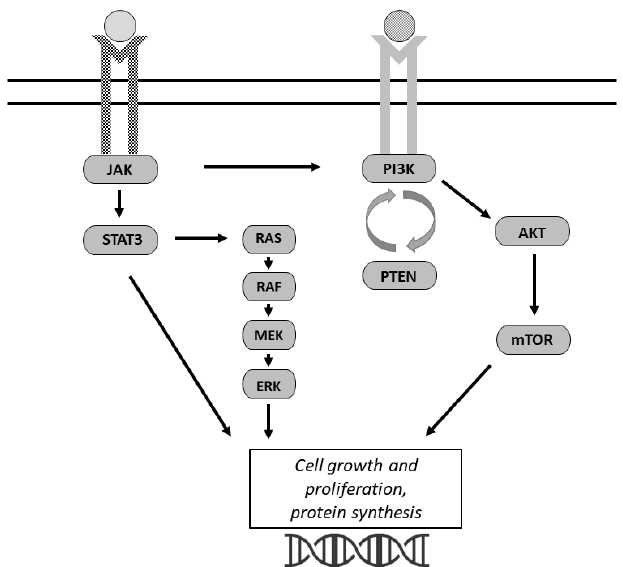
Figure 2. Signaling pathways altered in ovarian cancer cells. There is extensive crosstalk between the pathways depicted. The JAK/STAT signaling pathway and the PI3K/AKT/mTOR signaling pathway both regulate cell growth and proliferation. The JAK/STAT pathway activates PI3K as well as the MAPK signaling to stimulate downstream growth. The pathways shown also impact angiogenesis and cell migration.